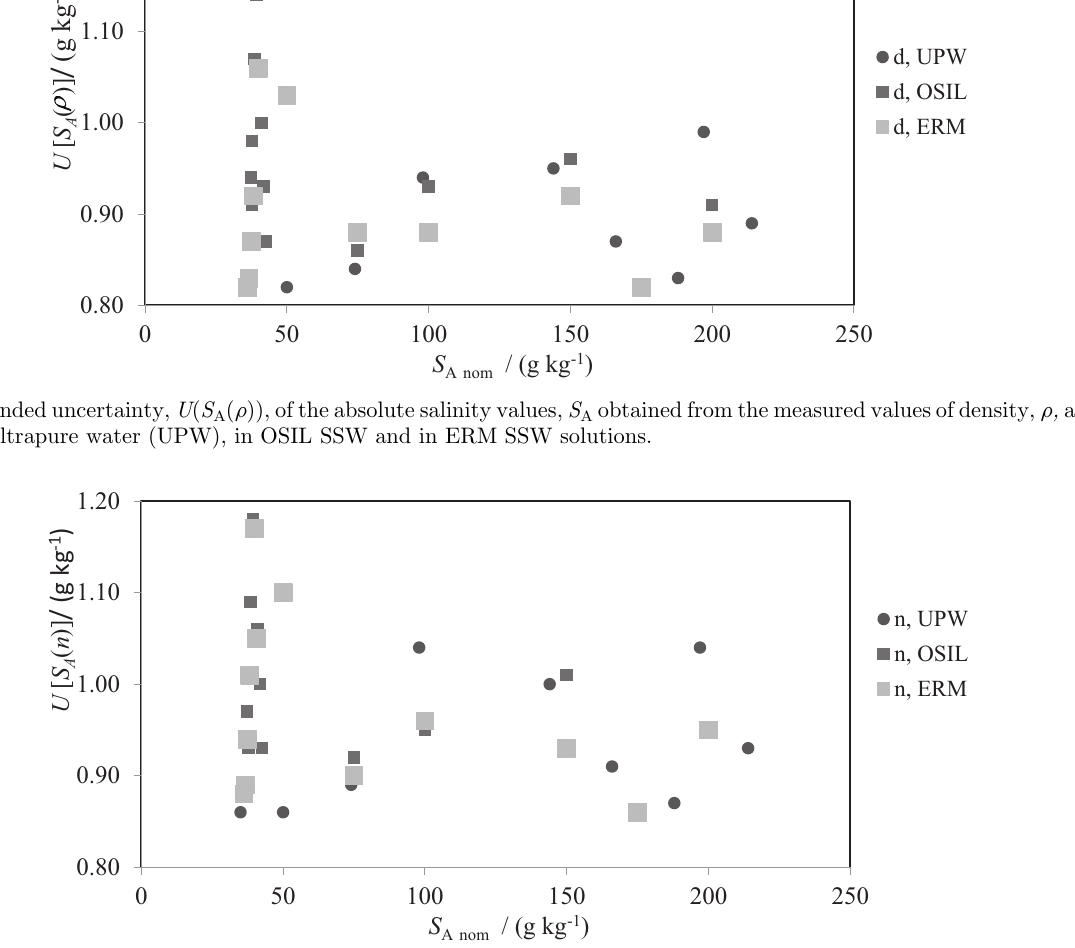
Fig. 5. Expanded uncertainty, U ( S A ( n )), of the absolute salinity values, S A obtained from the refractive index, n , at 20 ° C, for NaCl in ultrapure water (UPW), in OSIL SSW and in ERM SSW